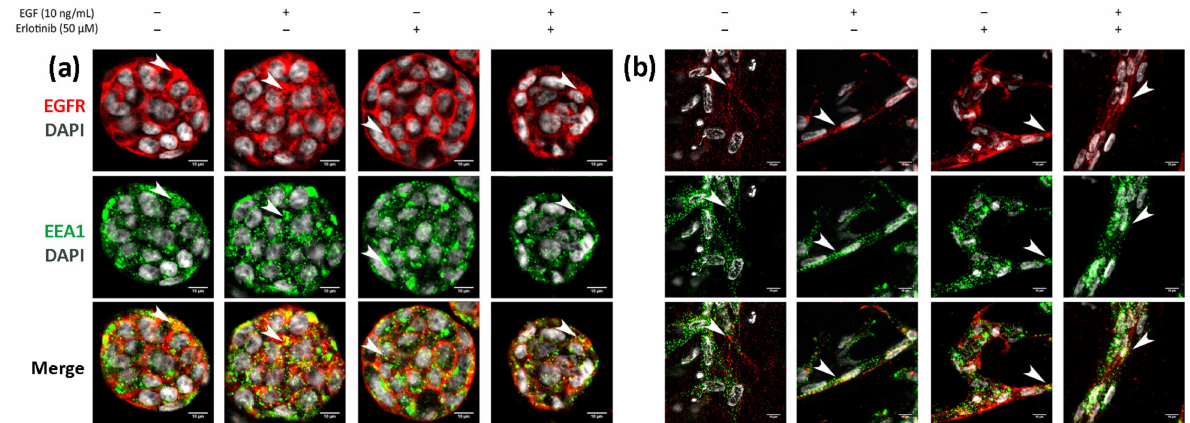
Figure 11. Immunofluorescence of EGFR and EEA1 in ( a ) BxPC-3 cells and ( b ) hNDF incubated with EGF, erlotinib or both in 0.15% RAD16-I 3D cultures. One representative Z plane is shown. Scale bars represent 10 µ m. White arrows show EGFR colocalizing with early endosomes.